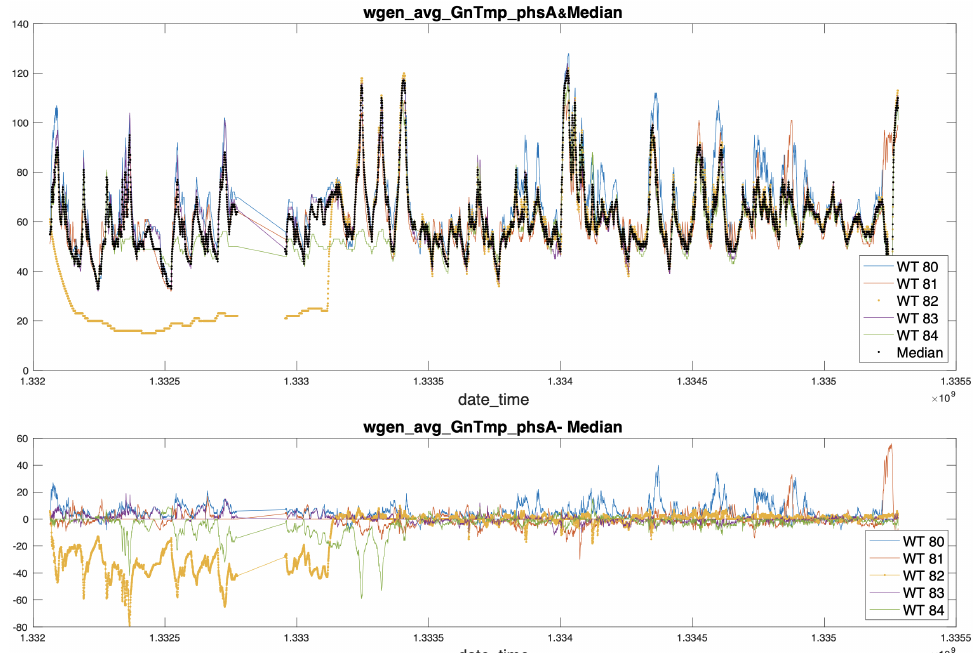
Figure 4. The upper plot shows the median (reference) signal in black, overlaid on the data of the different WTs. In the lower plot, the differences of the signals of each WT with respect to the reference signal are shown. Each of these residuals provides a visual representation of the deviation of the individual WTs from the reference